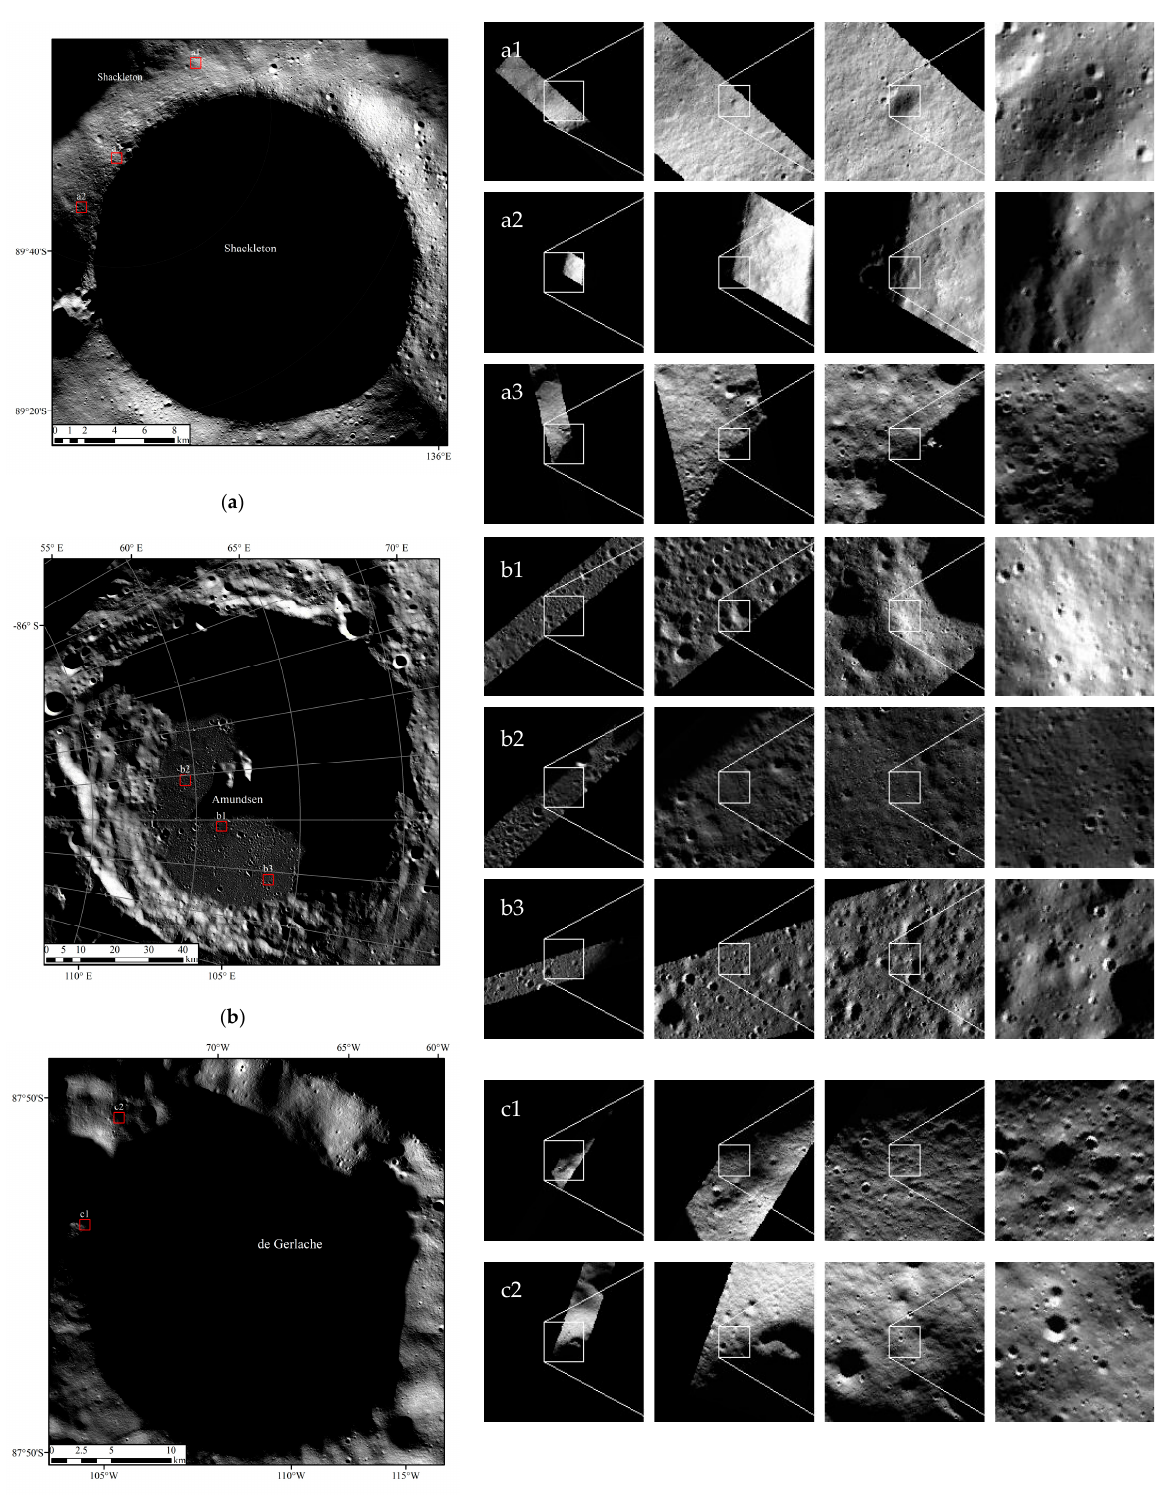
Figure 17. Site selection area analysis. ( a ) Orthographic image of the Shackleton impact crater (( a1 ): Image from LRO LROC NAC M140218222L, ( a2 ): M108435844R, ( a3 ): M142348843R). ( b ) Or- thographic image of the Amundsen impact crater (( b1 ): M1164484636R, ( b2 ): M1253940760L, ( b3 ): M1105440169L). ( c ) Orthographic image of the de Gerlache impact crater (( c1 ): M1130444179R, ( c2 ): M139783961R). Red boxes indicate areas of interest. ( a1 – c2 ) represent locally enlarged